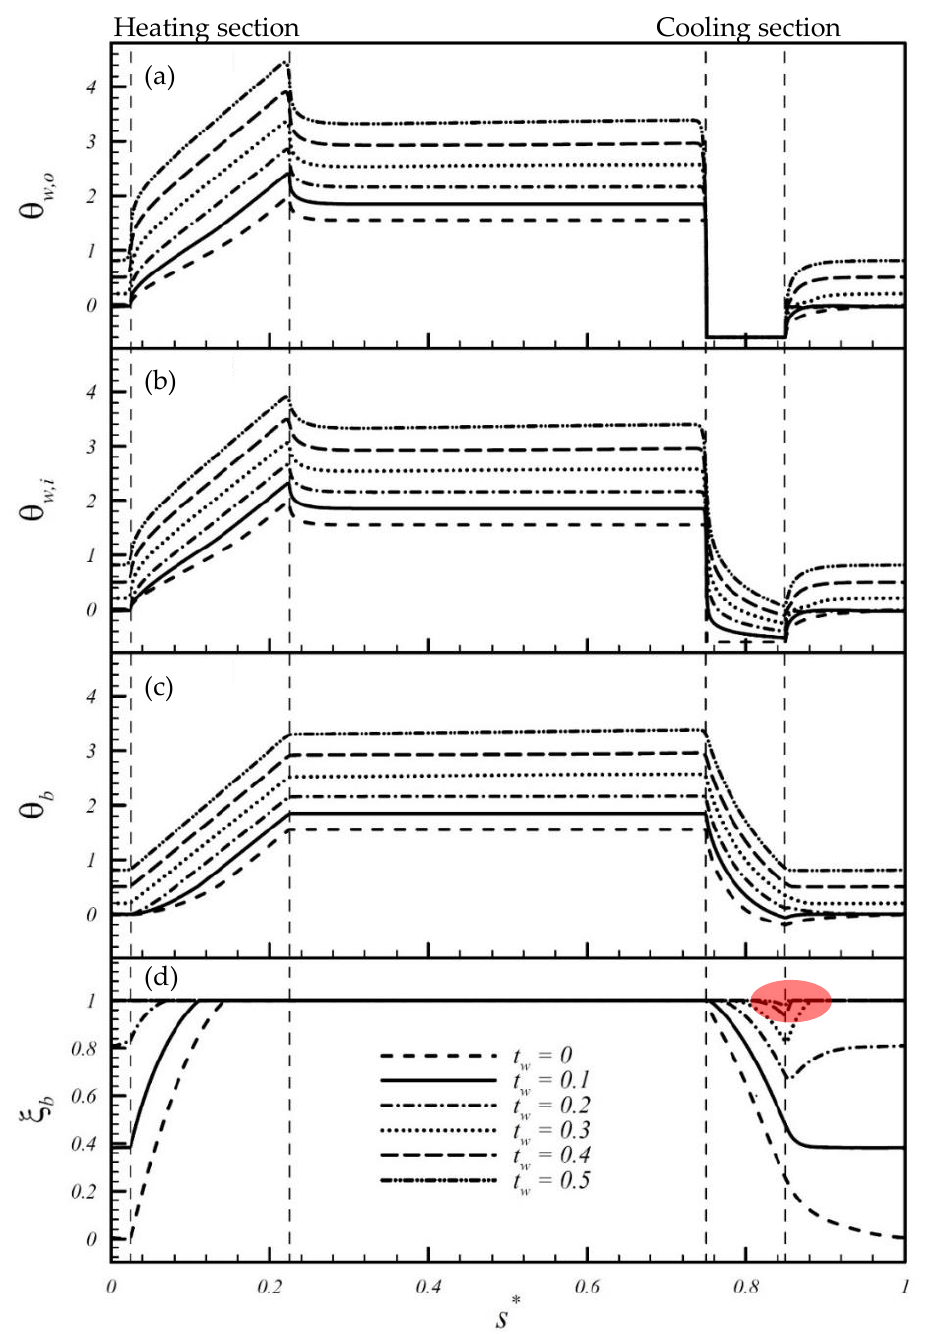
Figure 2. Axial distributions of the loop temperatures (( a ) θ w , o , ( b ) θ w , i , and ( c ) θ b ) and ( d ) b at various 𝑡 𝑤 ( AR = 1, 𝑙 ℎ∗ = 0.8, 𝑙 𝑧 = 2, 𝑆𝑏 ∗ = 0.6, 𝑆𝑡𝑒 ∗ = 0.1, 𝑅𝑎 ∗ = 10 10 , 𝑐 𝑣 = 10%, and 𝑘 𝑤𝑓∗ = 1).